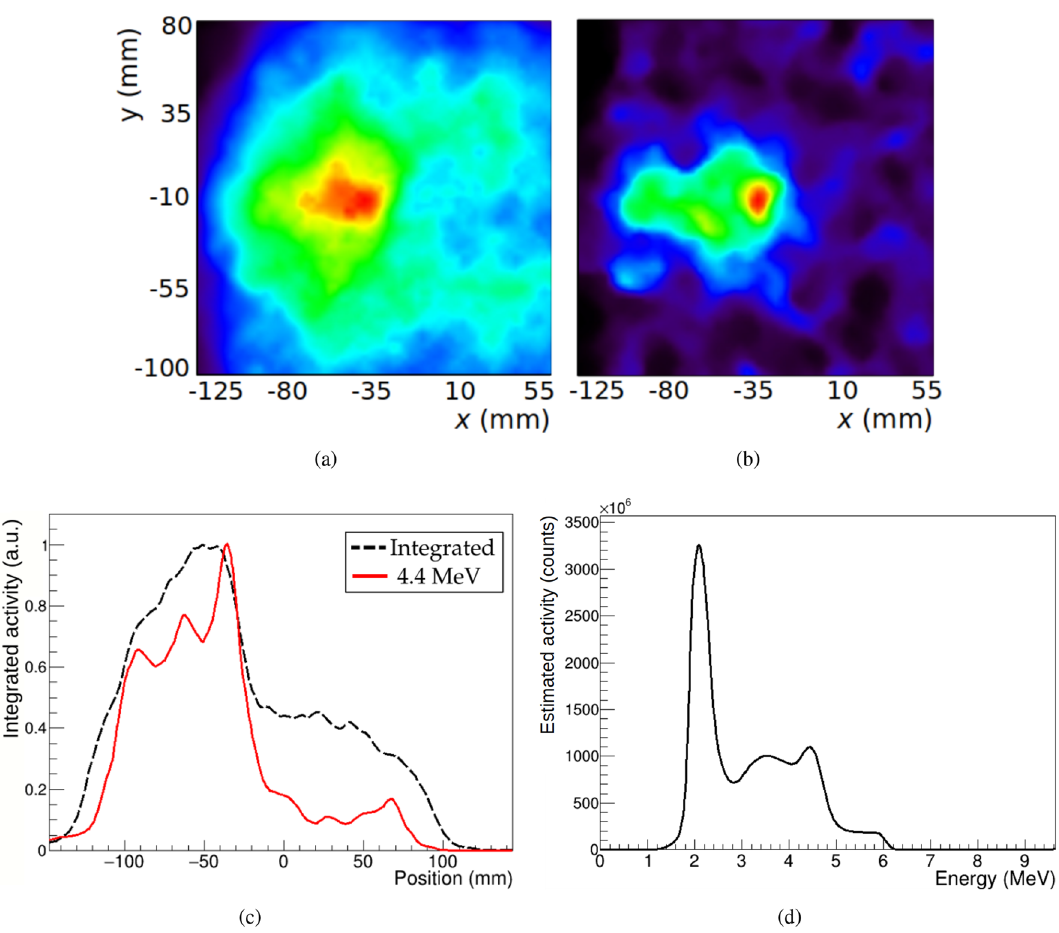
Figure 2. Reconstructed image from measurement at position 0. ( a ) Image integrated over the whole spectral domain. ( b ) Image obtained at the energy slices of 4.4 MeV. ( c ) Line profiles along the beam direction from the above images: whole energy range (black dashed line) and 4.4 MeV (red solid line). ( d ) Energy Spectrum recovered after integration over the reconstructed image spatial Reconstructed images with experimental data.